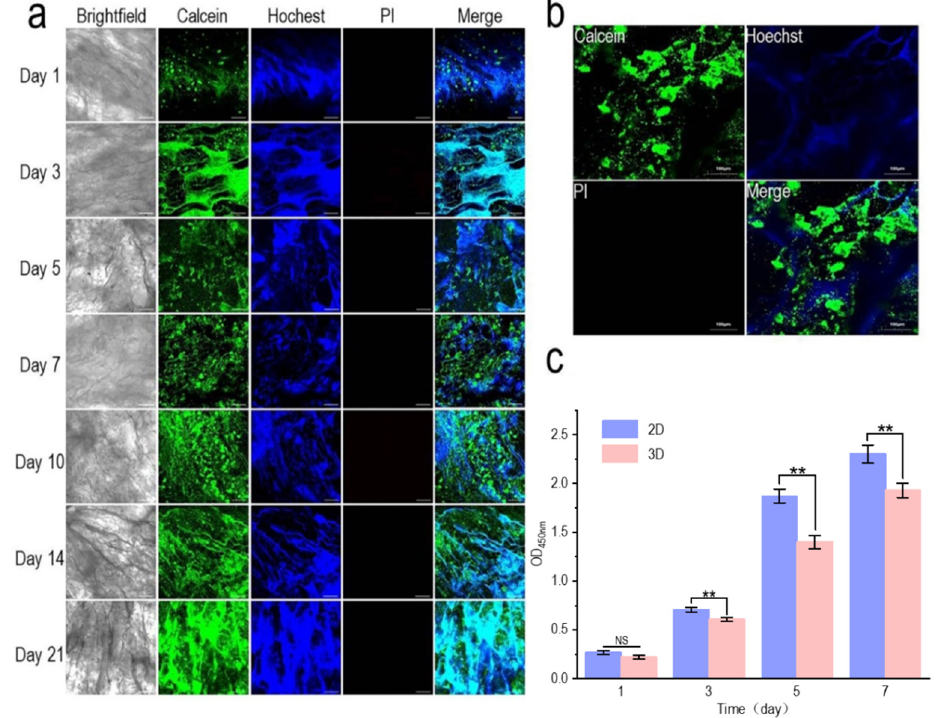
Figure 5. Growth of breast cancer (MCF-7) cells on pig renal matrix scaffolds. ( a ) MCF-7 cells were grown on the piglet renal matrix scaffold for 1, 3, 5, 7, 10, 14, and 21 days. The cells were dyed alive with calcein-Am, PI, and Hoechst 33,342, respectively; scale: 200 μ m. ( b ) Dead and alive staining of MCF-7 cells on the pig renal matrix scaffold after 7 days growth, scale: 100 μ m. ( c ) The survival of MCF-7 cells growing on 24-well plates and nephron-derived matrix scaffolds for 1 to 7 days was measured by CCK-8; NS, p > 0.05; ** p < 0.01.